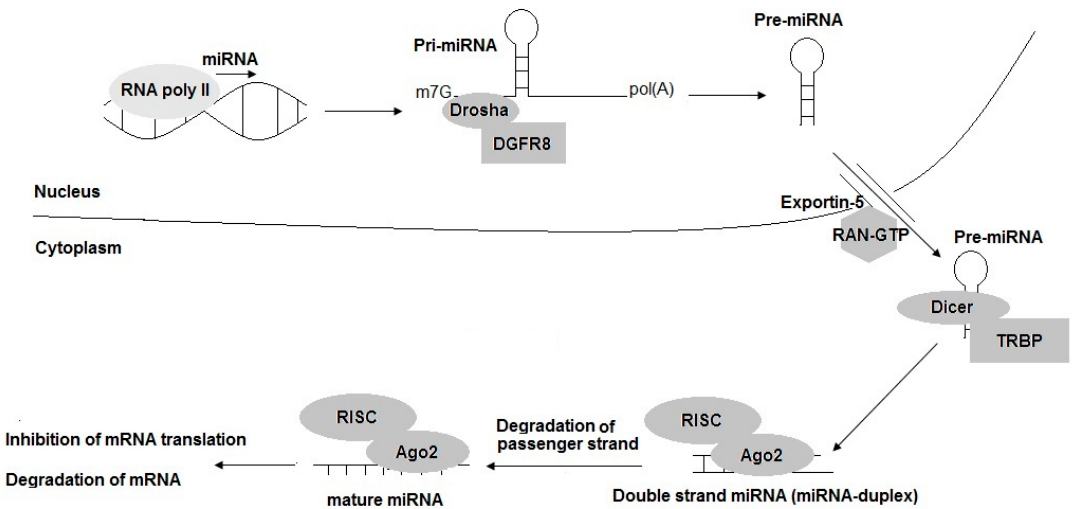
Figure 2. The biogenesis of miRNAs: the canonical pathway. pri-miRNA: primary miRNA; pre-miRNA: precursor miRNA; DGCR8: DiGeorge syndrome critical region 8; RAN-GTP: Ras-related nuclear protein guanosine triphosphate; TRBP: transactivation-responsive RNA-binding protein; Ago: Argonaute protein; RISC: RNA-induced silencing complex; miRISC: miRNA-induced silencing complex.